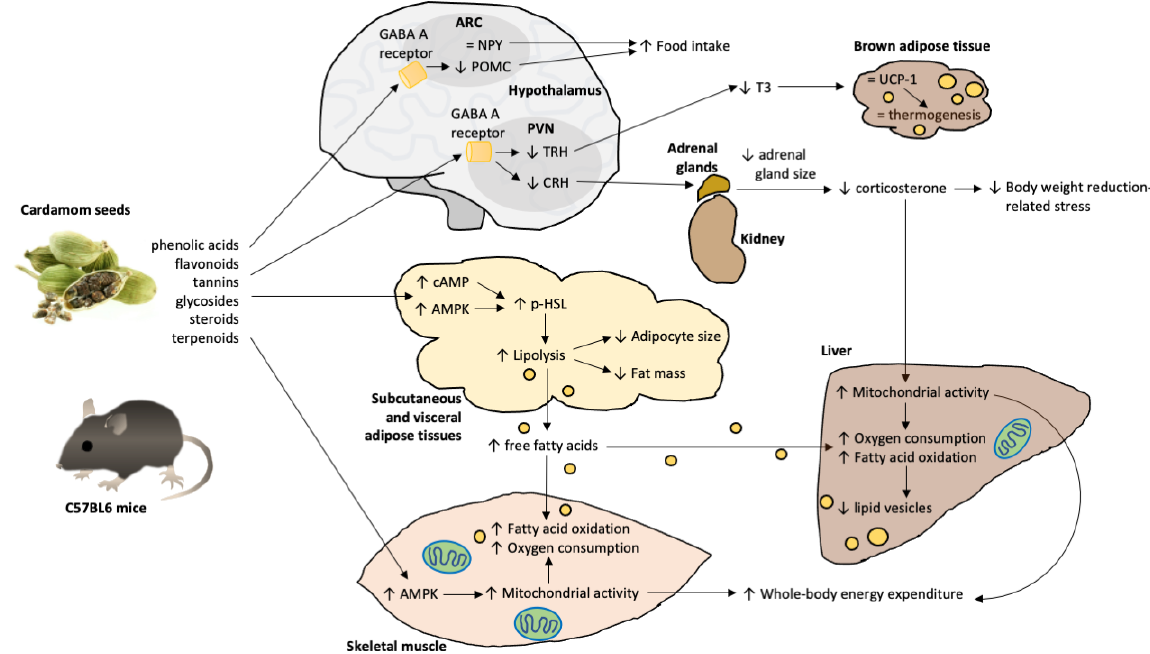
Figure 8. Scenario 1: Parallel central and peripheral effects of cardamom intake regulating energy metabolism. The different compounds present in cardamom seeds exerted central and peripheral effects modulating energy balance in mice. Central effects include the modulation of NPY and POMC expression, the hypothalamic peptides controlling food intake and energy expenditure, probably by activation of the GABA A receptor. The activity of the TRH and CRH neurons in the paraventricular nucleus (PVN) are also modulated by GABA A receptors. These neurons regulate the circulating levels of triiodothyronine (T 3 ) and corticosterone. The metabolic activities of T 3 in peripheral tissues include the activation of uncoupling protein 1 (UCP-1) mediated thermogenesis in brown adipose tissue. Cardamom seeds also exerted peripheral effects in adipose tissue, skeletal muscle and the liver, in part by increasing AMP-activated protein kinase (AMPK). AMPK signaling in adipose tissue increased lipolysis by activation of hormone sensitive lipase (HSL). In skeletal muscle and liver, AMPK increases oxidative capacity by increasing mitochondrial biogenesis and activity. Conversely, chronic corticosterone signaling impairs mitochondrial biogenesis and function. Thus, the reduction in circulating corticosterone by cardamom consumption favors oxidative metabolism in metabolic tissues, reducing body fat by increasing lipolysis and whole-body energy expenditure through augmented mitochondrial activity in skeletal muscle and liver. Upwards arrow = upregulation, downwards arrow =